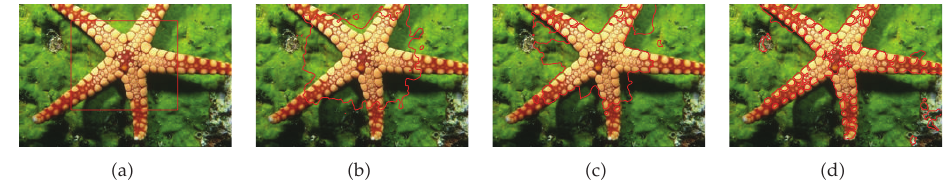
Figure 9: Results of the proposed model for a color image of starfish. (cid:6) a (cid:7) – (cid:6) d (cid:7) show the curve evolution process from the initial contour to the final